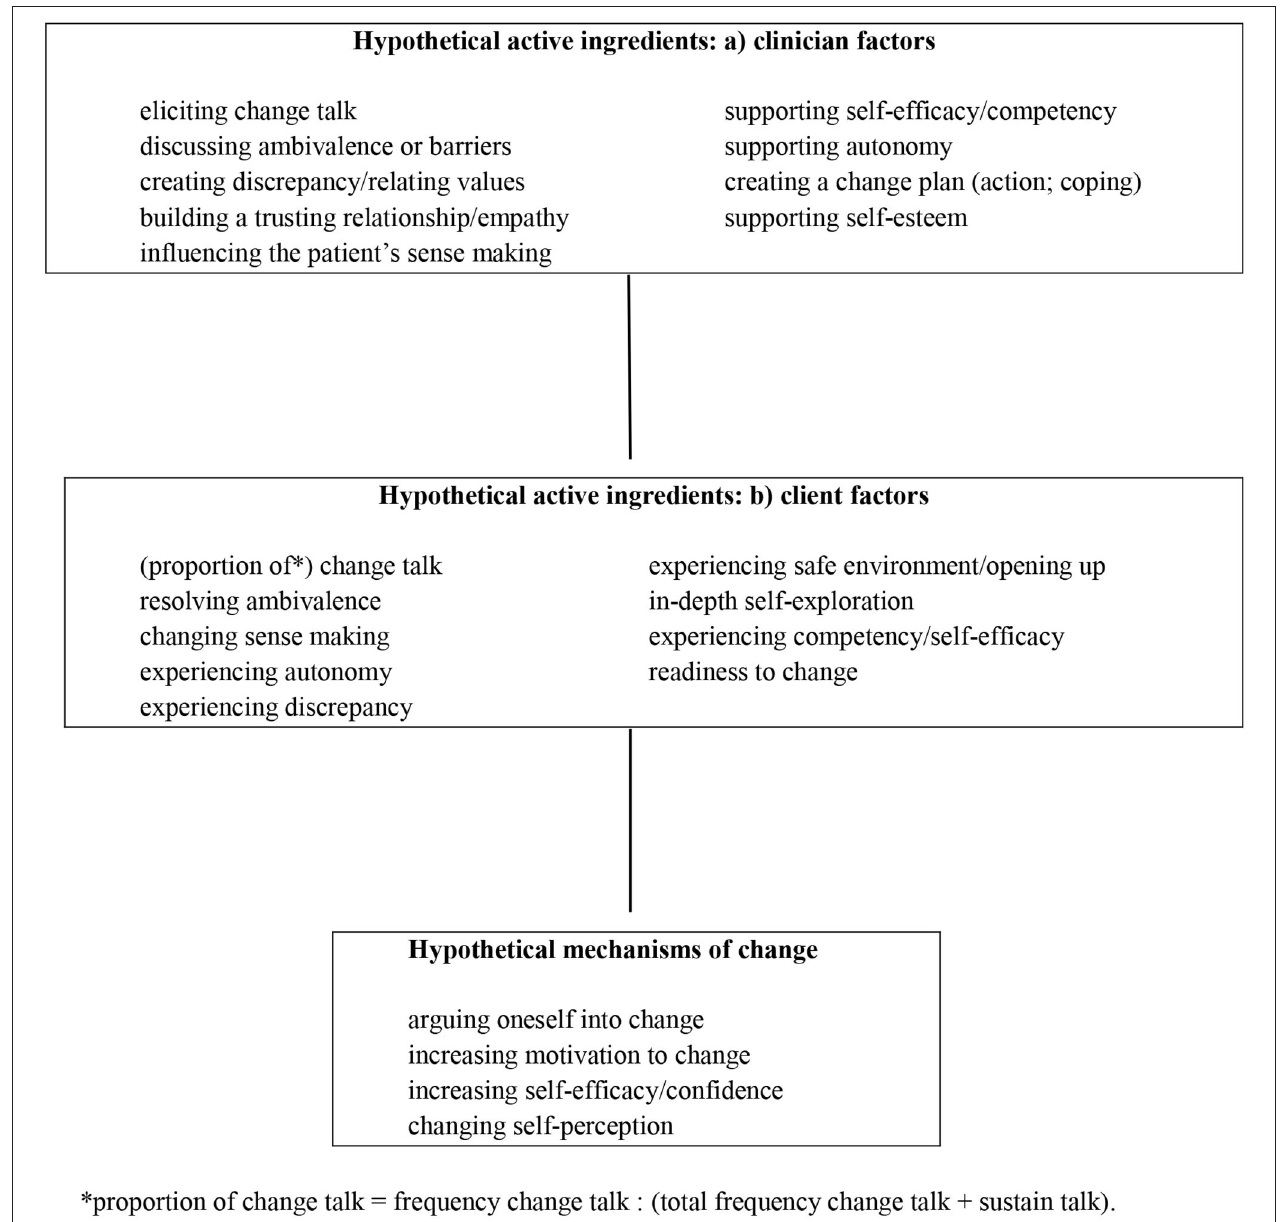
FIGURE 1 | Model of hypothetical active ingredients and mechanisms of change in MI.